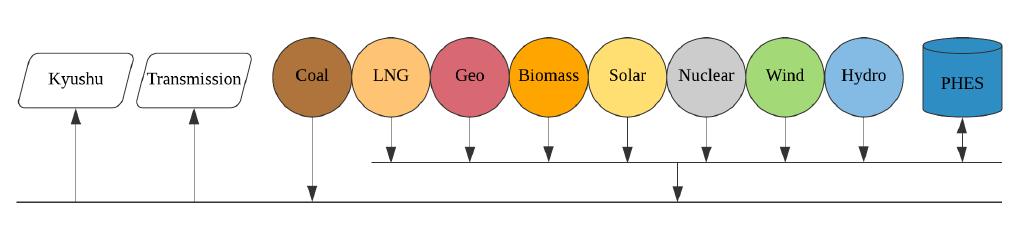
Figure 8. Configuration of the single-bus network used in the